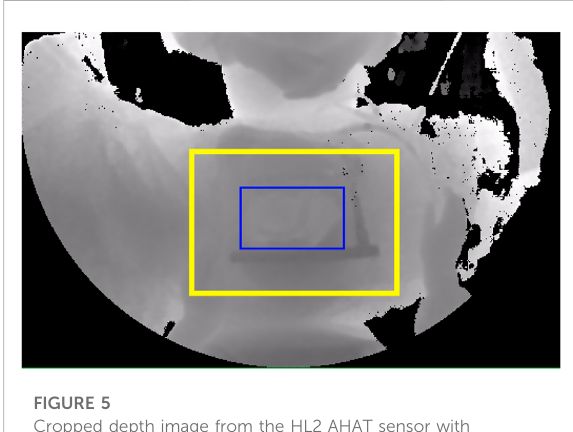
FIGURE 5 Cropped depth image from the HL2 AHAT sensor with depiction of the transmitted full-resolution region of interest (ROI) (yellow border) and the actual situs (blue